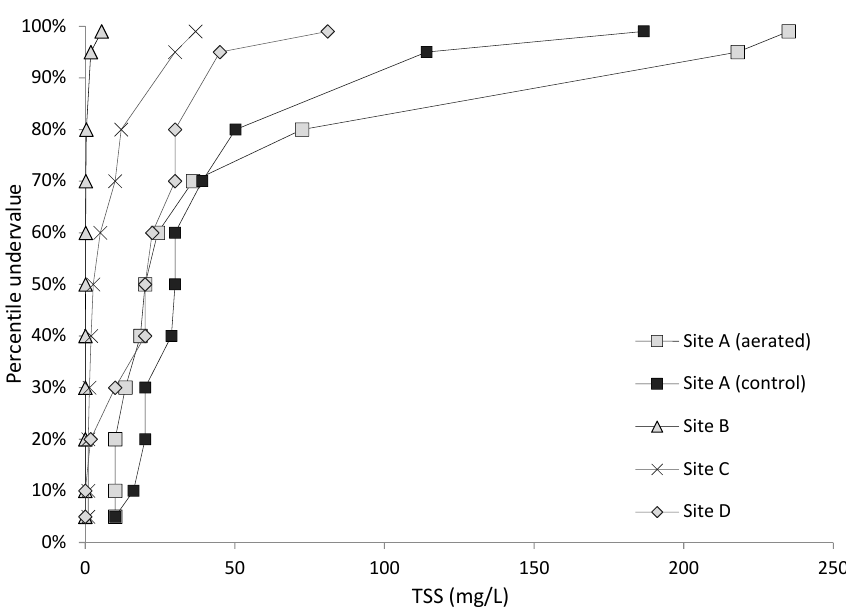
Figure 9. TSS removal robustness curves for all sites.